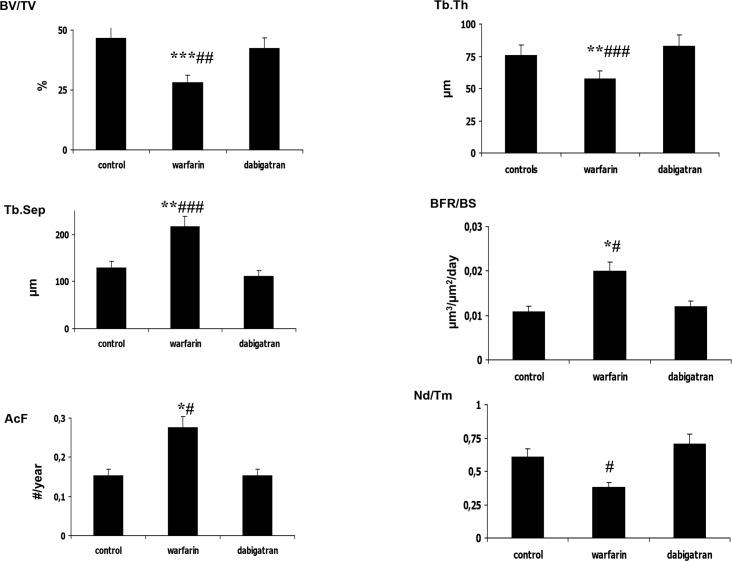
Significant histomorphometric results of structural and dynamic parameters in femur rats.In warfarin treated rats we observed lower bone volume and trabecular thickness with increased trabecular separation compared to dabigatran treated and control rats. In addition, treatment with warfarin was associated with a significant increase of turnover parameters (i.e. BFR/BS) and, in particular, activation frequency was higher in warfarin treated rats versus dabigatran treated or control rats. Microarchitecture, cortical thickness and porosity were similar among groups. Only rats treated with warfarin showed an alteration of bone volume and structure, suggesting increased bone fragility compared to dabigatran and control rats pattern. For the meaning of abbreviations see Table 2. *p<0.05, **p< 0.01, ***p<0.001 vs control; # p<0.05, ##p< 0.01, ### p<0.001 vs dabigatran.